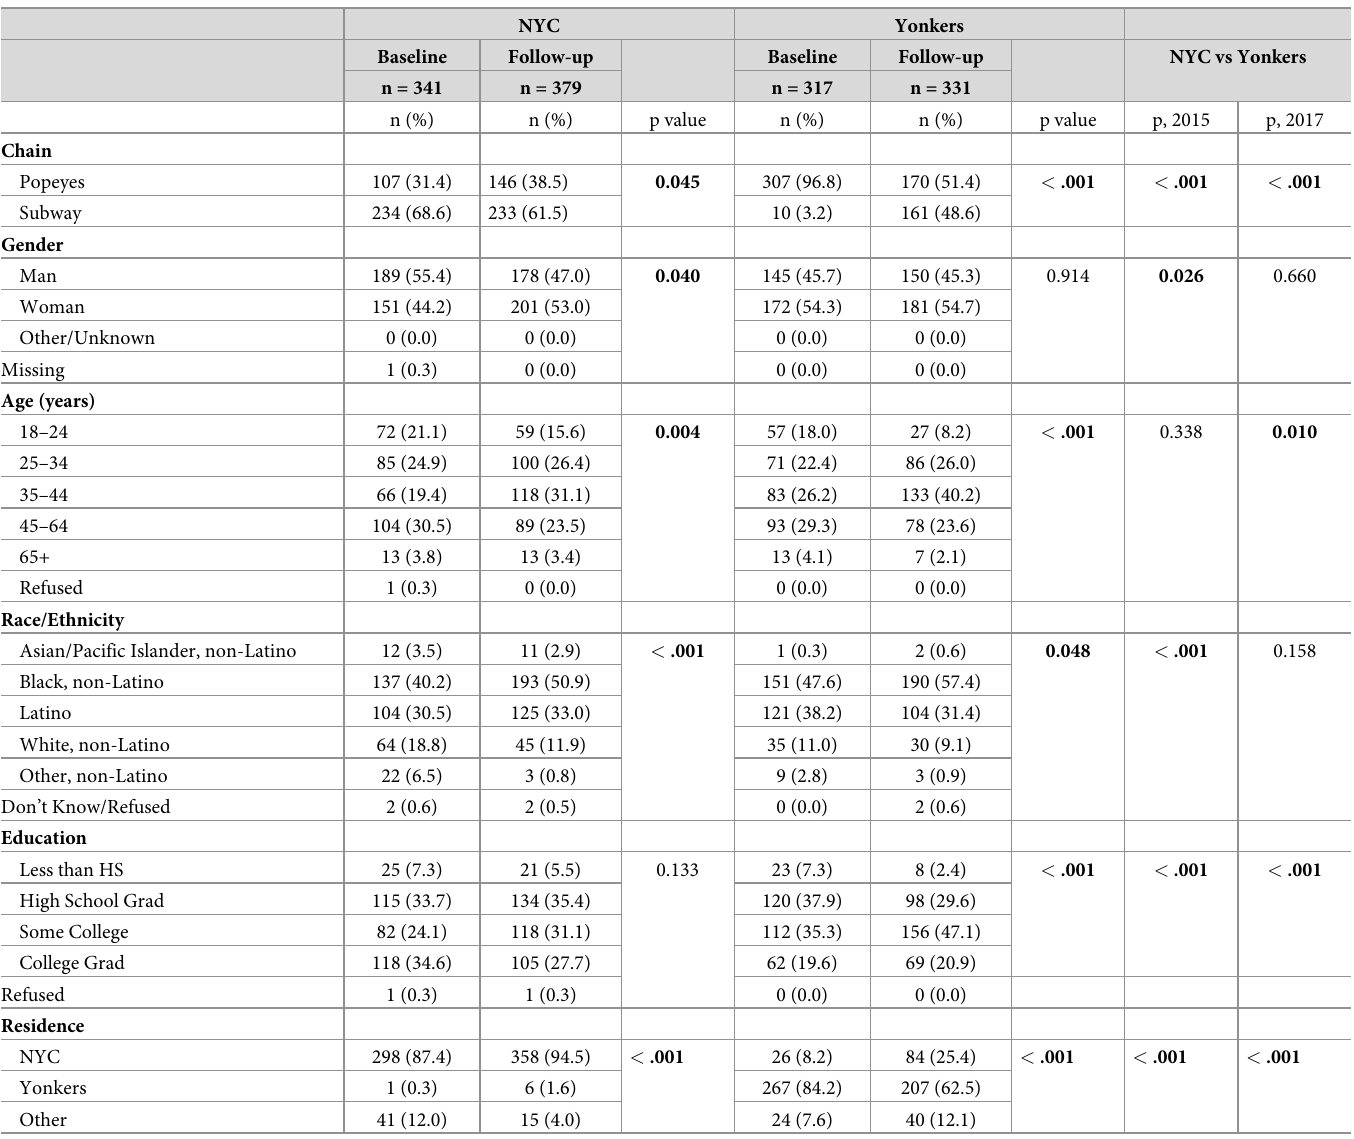
Table 2. Participant characteristics at baseline and follow-up, quick-service